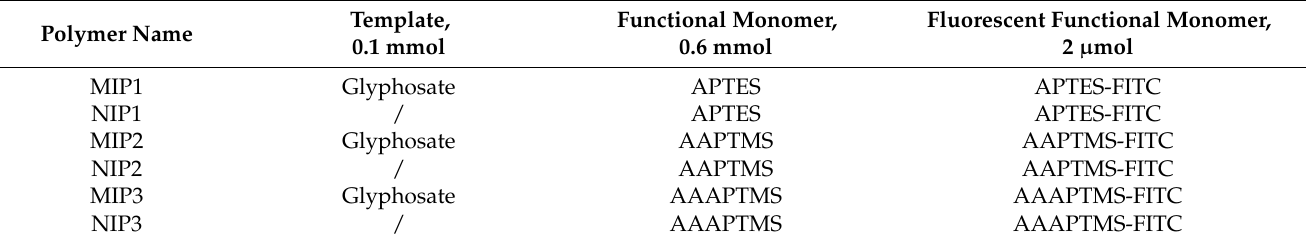
Table 1. Content of the polymerization mixture for MIP